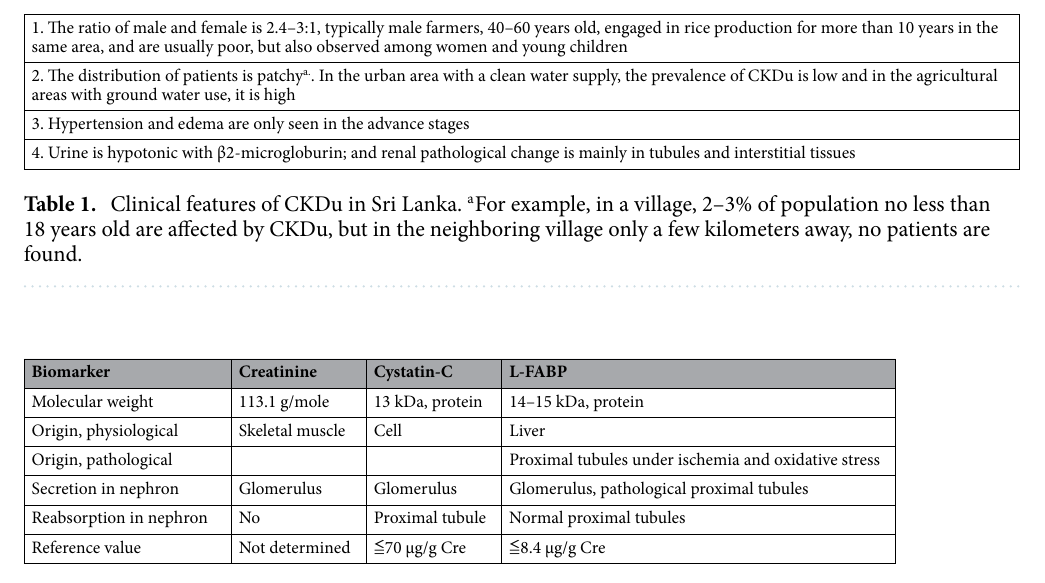
Table 2. Comparison of the characteristics of three urinary biomarkers.